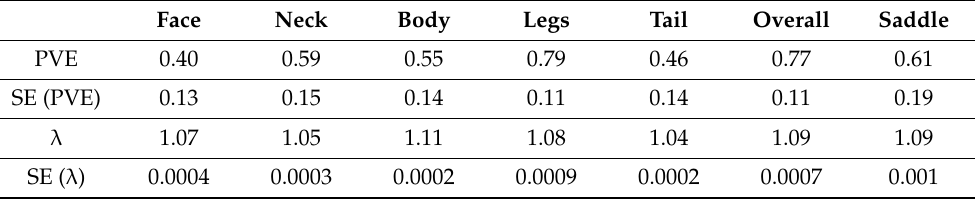
Figure 2. Spearman correlation of the amount of white in the fur coloration phenotypes. The boxes show the correlation coefficients with a corresponding color intensity. ** = p < 0.01; * = p < 0.05. Table 2. Proportion of variance explaine (PVE) or “chip heritability” and λ (genomic inflation factor) from the GWAS analysis in